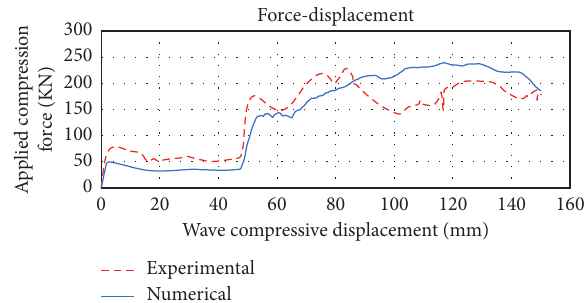
Figure 4: Comparison of axial force-displacement results of experimental and numerical models.